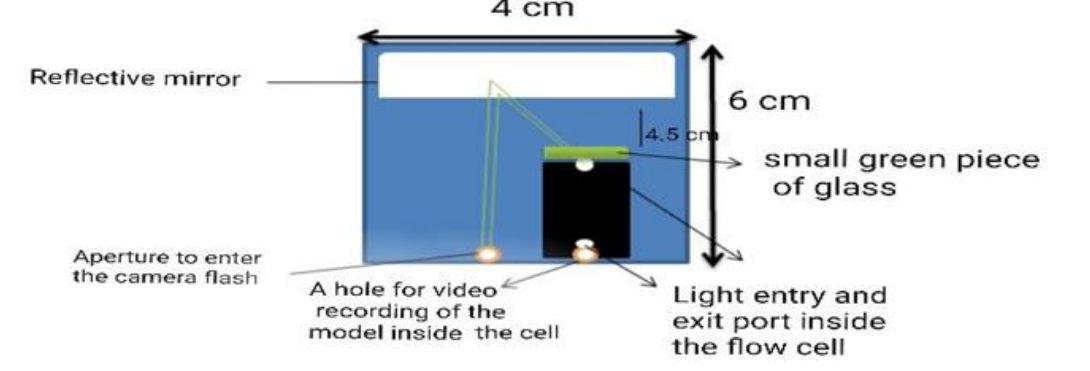
Fig. 3. Diagram of the design of a box attached to a smartphone